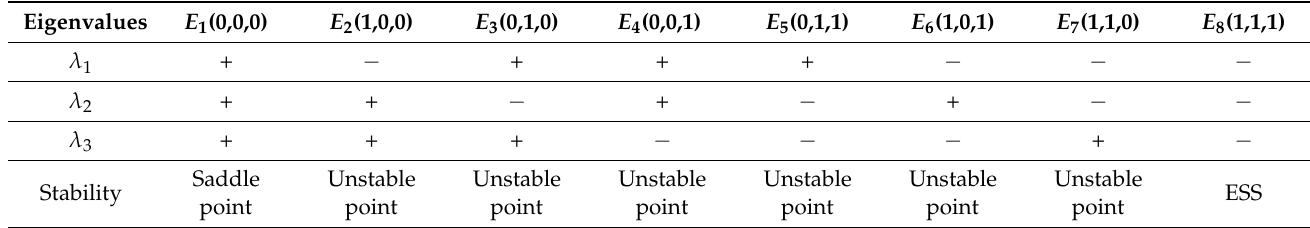
Table 8. Local stability of equilibrium points of tripartite evolutionary